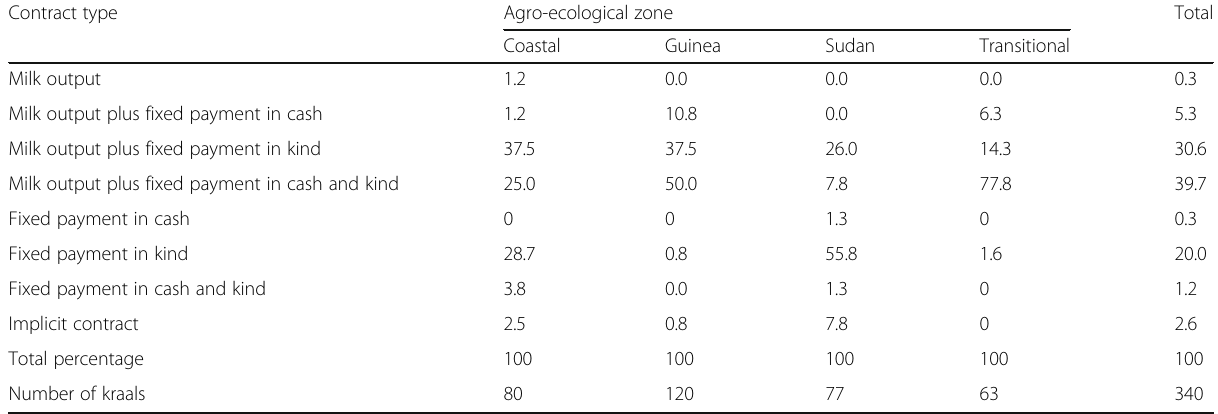
Table 4 Distribution (percentage) of kraal owner – herdsman contract types by agro-ecological zone Contract type